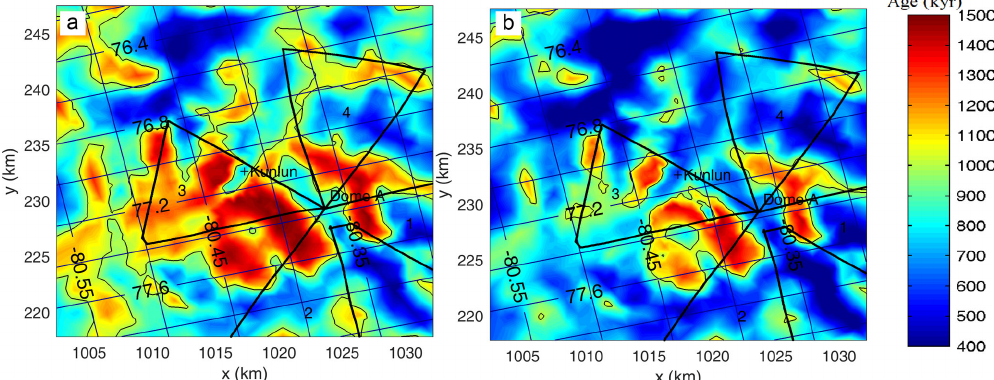
Figure 6. Modeled age at a height of 200m above the bedrock using Kunlun fabric and a geothermal heat flux of 55mWm − 2 (a) and 60mWm − 2 (b) in the standard grid coordinate system (unit: km, see Fig. 1), and WGS 1984 latitude and longitudes (inclined grid with the South Pole to the lower left). Kunlun station is marked by a black plus sign. The black curve is the 1Ma age contour. The thick black line marks the polarimetric radar survey route triangles marked in Fig.